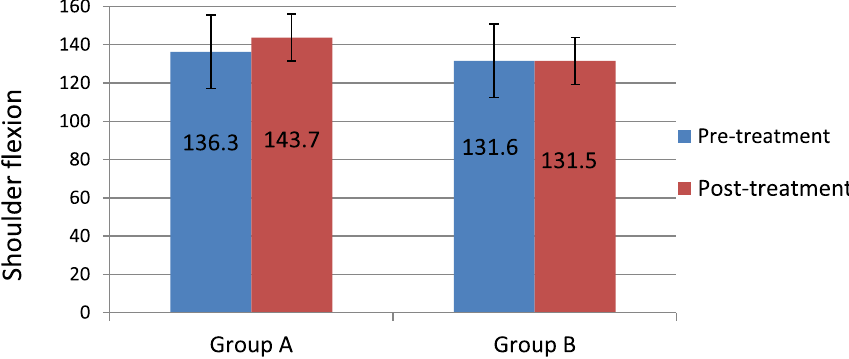
Fig. 9 Mean values of shoulder flexion pre- and post-treatment within each